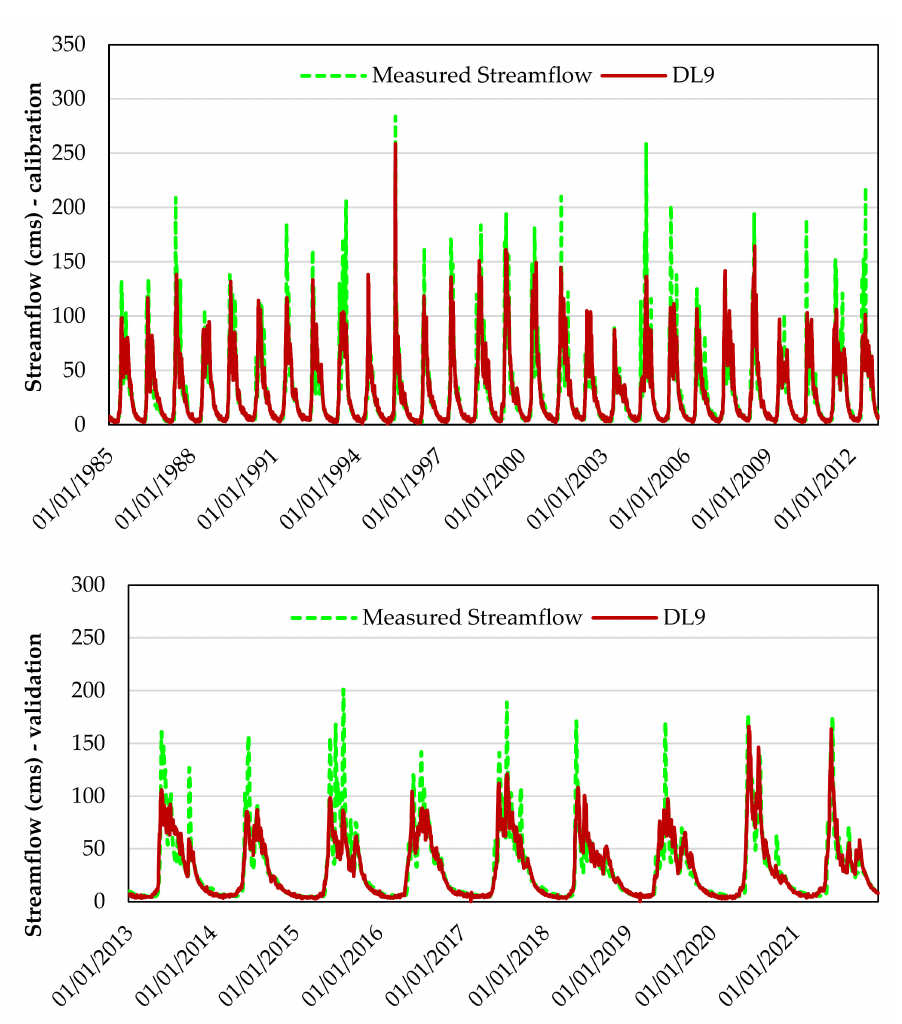
Figure 8. Hydrograph of measured vs. simulated streamflow by